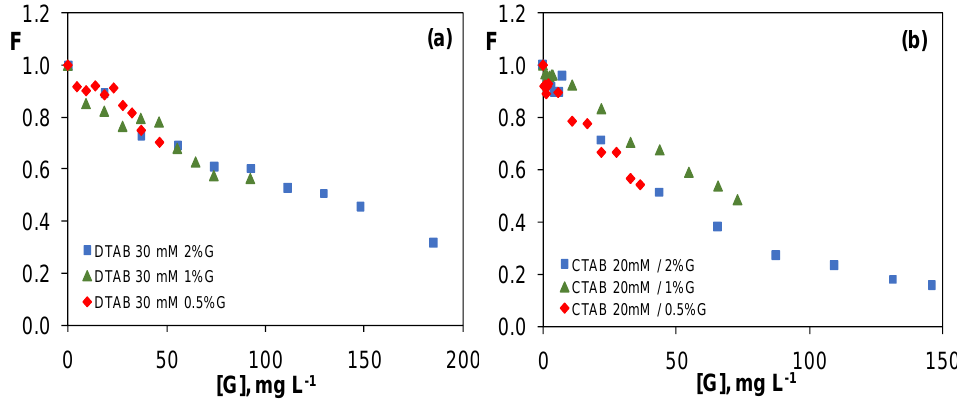
Figure 8. F ( λ exc = 325 nm; λ em = 395 nm) vs. G concentration for G dispersions with a constant surfactant concentration: 30 mM DTAB ( a ) and 20 mM CTAB ( b ).